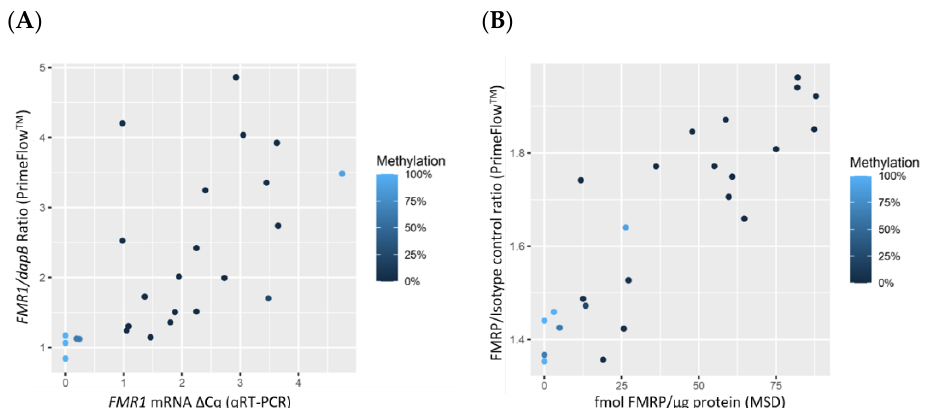
Figure 3. Scatterplots comparing methodologies to measure FMR1 ( n = 25) ( A ) and FMRP ( n = 24) ( B ) expression. Points are colored by % methylation, with lighter blue corresponding to more methylation and darker blue to less methylation. A small amount of random jitter is applied to the x-axis in order to better display overlapping